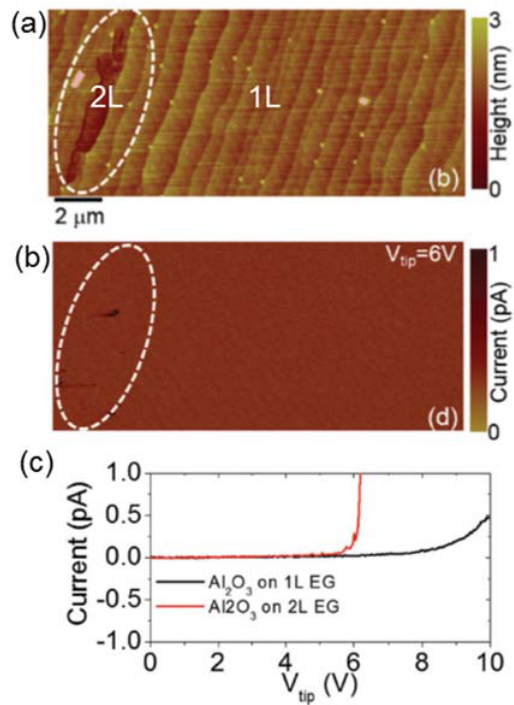
Figure 6. Conductive atomic force microscopy (C-AFM) local current mapping through an Al 2 O 3 thin film deposited onto EG on axis 4H-SiC(0001). ( a ) Morphology of the probed sample area, including both uniform Al 2 O 3 on 1 L EG and Al 2 O 3 on a 2 L EG patch. ( b ) Current map collected on this area with a tip bias V tip = 6 V. ( c ) Two representative local current-voltage characteristics collected by the C-AFM probe on Al 2 O 3 in the 1 L and 2 L EG regions. Images adapted with permission from Ref. [21], copyright Wiley 2019.